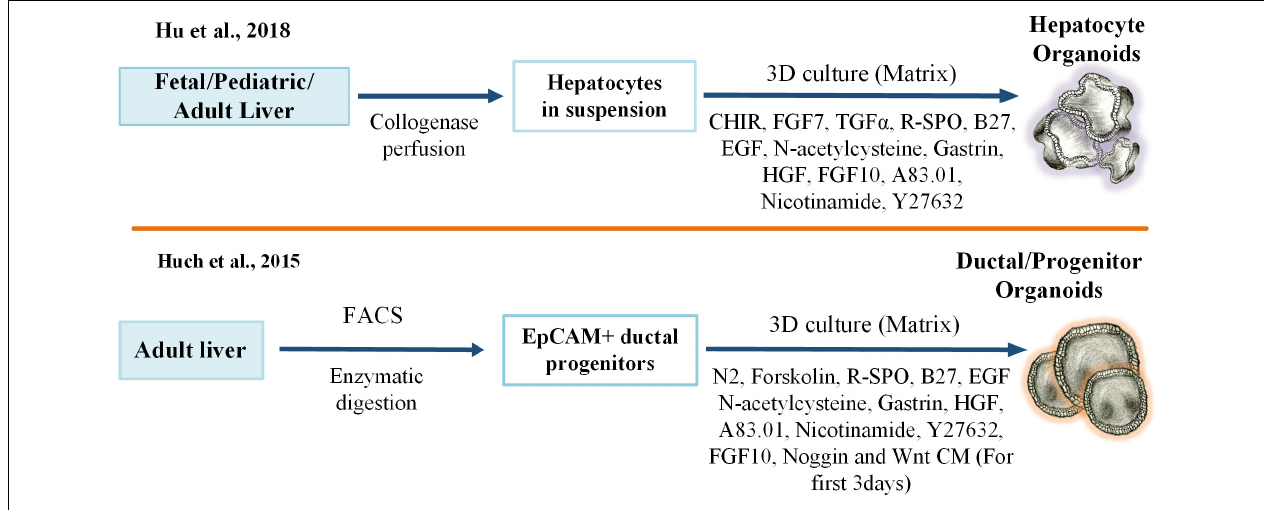
FIGURE 2 | Key protocols for developing adult liver stem cell-derived 3D liver organoid cultures. 3D, three-dimensional, FGF, Fibroblast Growth Factor; TGF, Transforming Growth Factor; R-SPO, R-Spondin; EGF, Epidermal Growth Factor; HGF, Hepatocyte Growth Factor; CM, Condition Medium; FACS, Fluorescence-Activated Cell Sorting; EpCAM, Epithelial Cell Adhesion